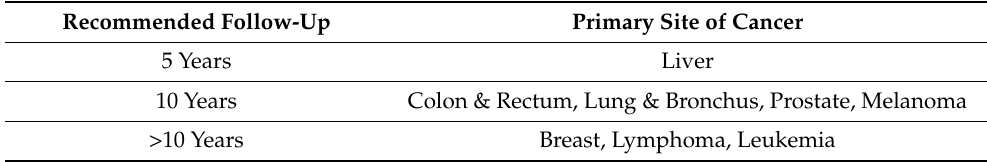
Table 4. The recommended follow-up period based on the increased risk of SPTC for common primary